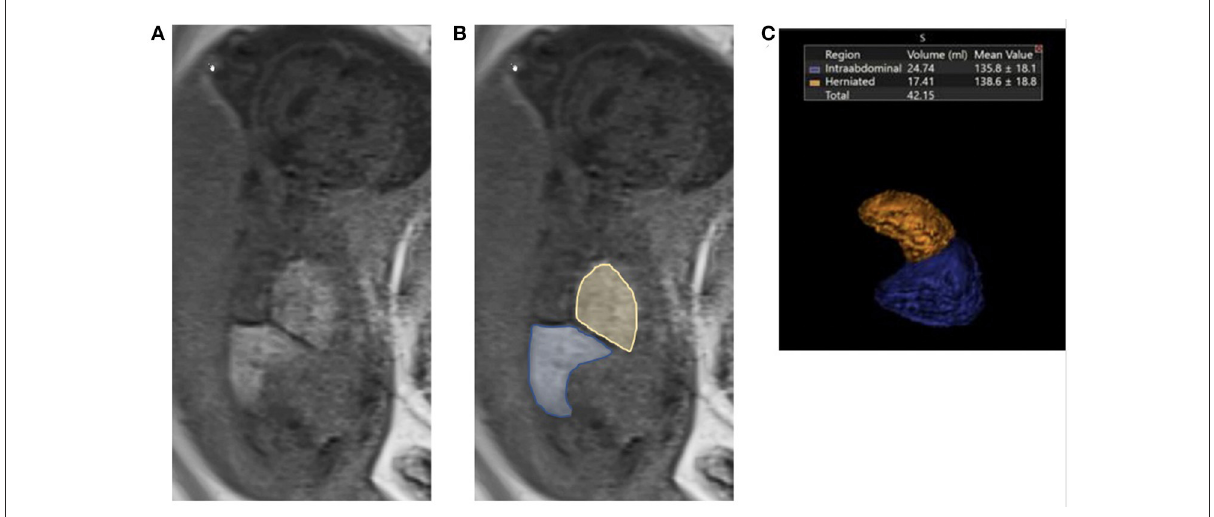
FIGURE1 Fetal liver volumetry using T1 MRI images. (A) Liver down (blue) and liver up (yellow) volumes were determined on each MRI section by using a free-form region of interest on a Vitrea workstation (Vital Images Inc, Minnetonka, MN). (B) Delineation of the liver up and liver down on the ipsilateral site of defect was determined by mirroring the contour of the contralateral diaphragm. Liver volumes were then calculated in the T1-weighted coronal plane by using sequences that allowed complete imaging of the liver and without artifacts from motion and the summation. (C) Three dimensional representation of the liver volumes from the same